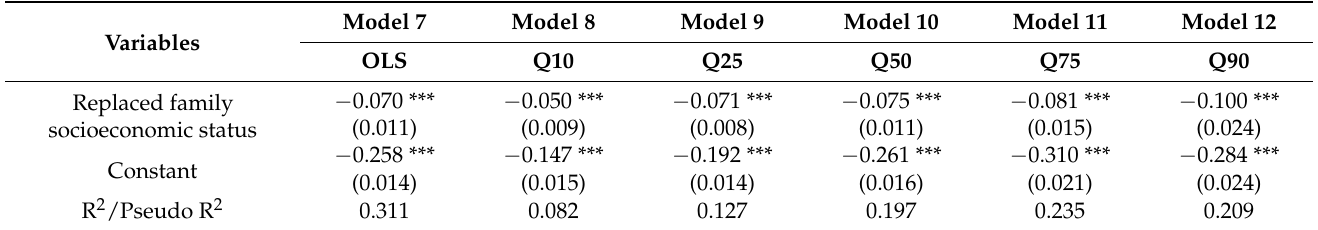
Table 3. Regression results after replacing the explanatory variable.